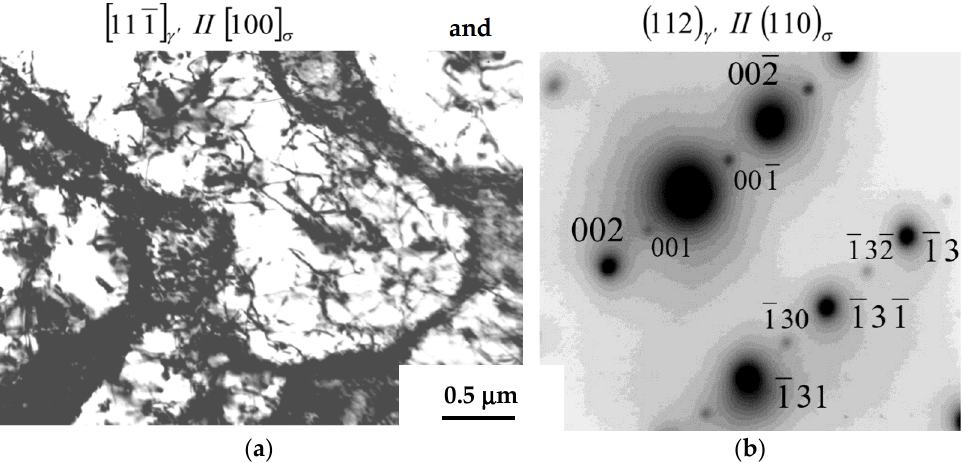
Figure 6. Electron microscopic image of a quasi-cuboid structure ( γ′ + γ ) in the alloy after DC and annealing (structural phase state “ А ′ ”): ( a ) bright-field image; ( b ) in the indicated microdiffraction pattern, there are reflections belonging to the (310) plane of the γ′ -phase.